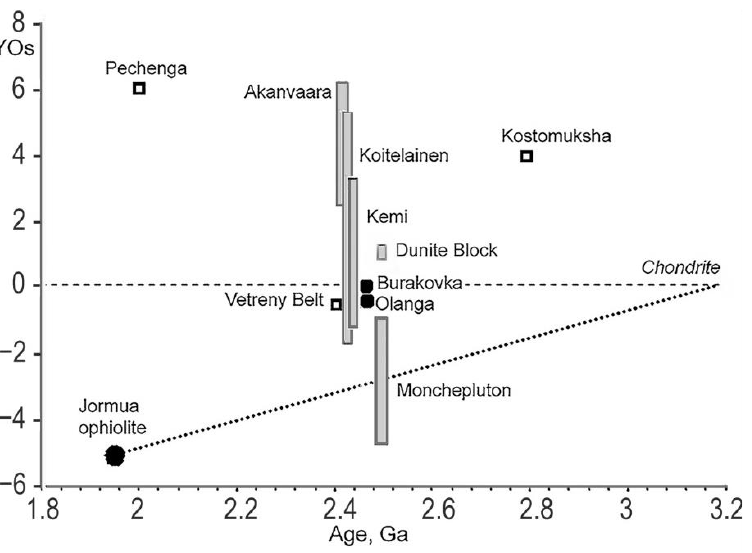
Figure 21. Variations in γOs ratio in chromite and layered intrusion rocks (Monchepluton, Burakovsky pluton, Akanvaara, Koitelainen, Kemi) and komatiitic basalts of the Vetreny Belt, modified after [3]. For comparison, the data on the Archean komatiites of Kostomuksha greenstone Belt and ophiolites of the Jormua Complex (Finland) and Paleoproterozoic ferropicrites of Pechenga (the Kola Region) are given. Data from [3,4,8,38,51 – 55].